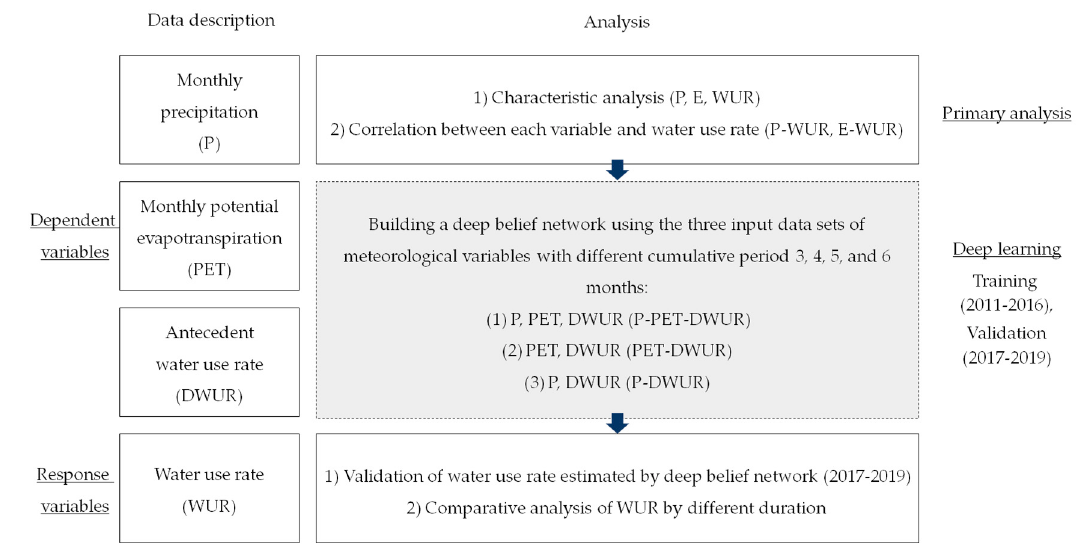
Figure 1. Procedure of this study.